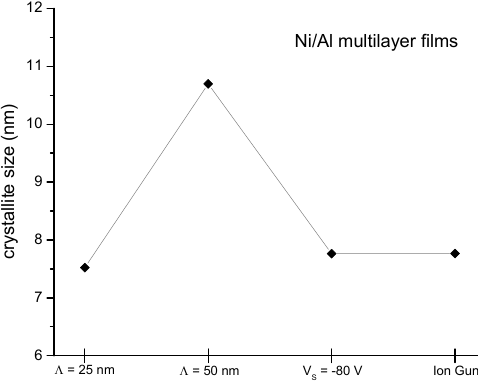
Figure 2. Crystalline size of the Al/Ni (V) multilayer films under study.